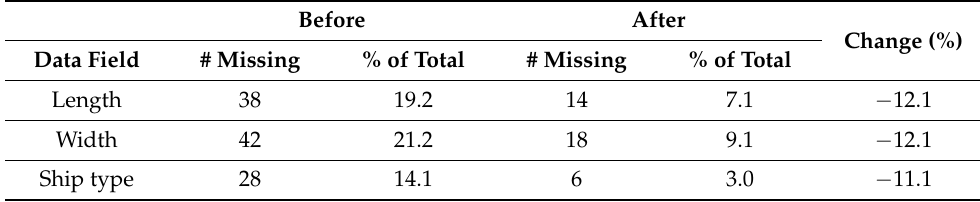
Table 6. English Channel missing data before and after cross-checking AIS data (total: 199).